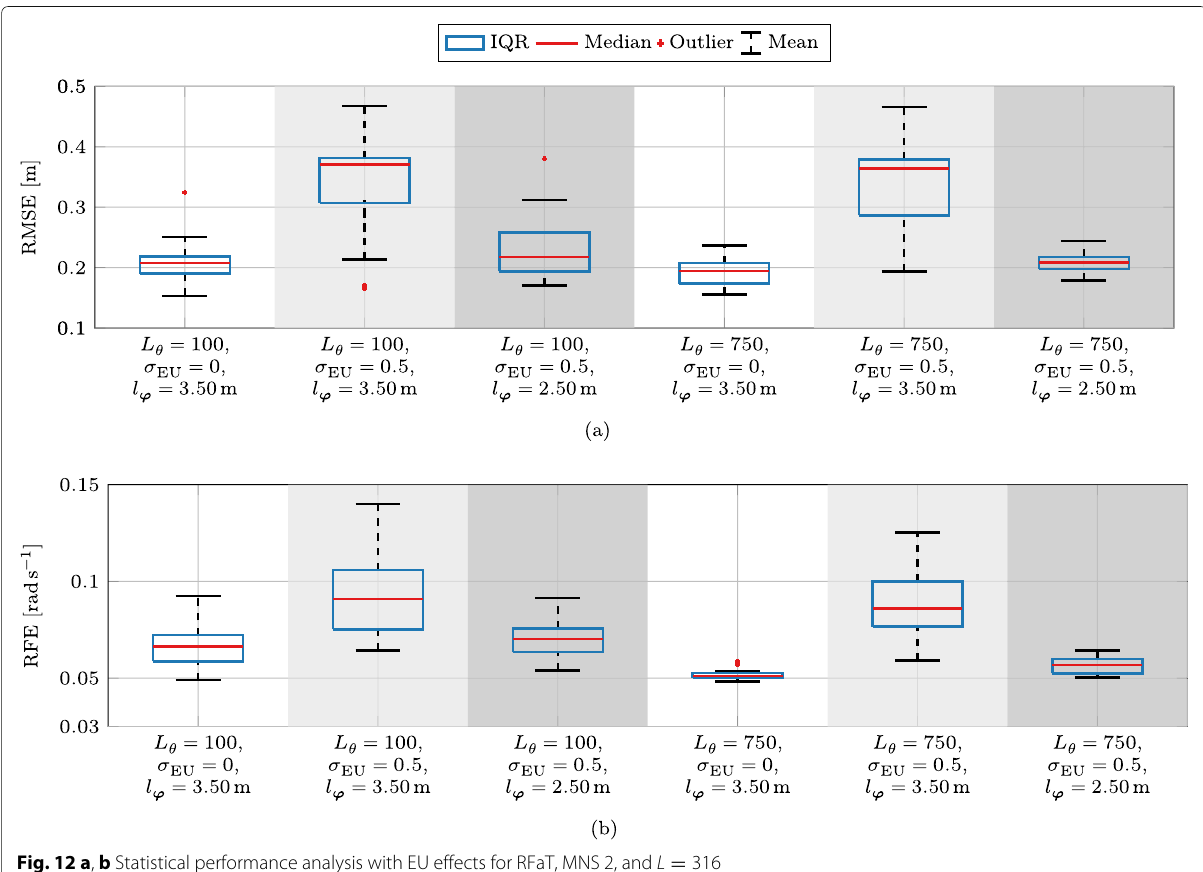
Fig. 12 a , b Statistical performance analysis with EU effects for RFaT, MNS 2, and L = 316